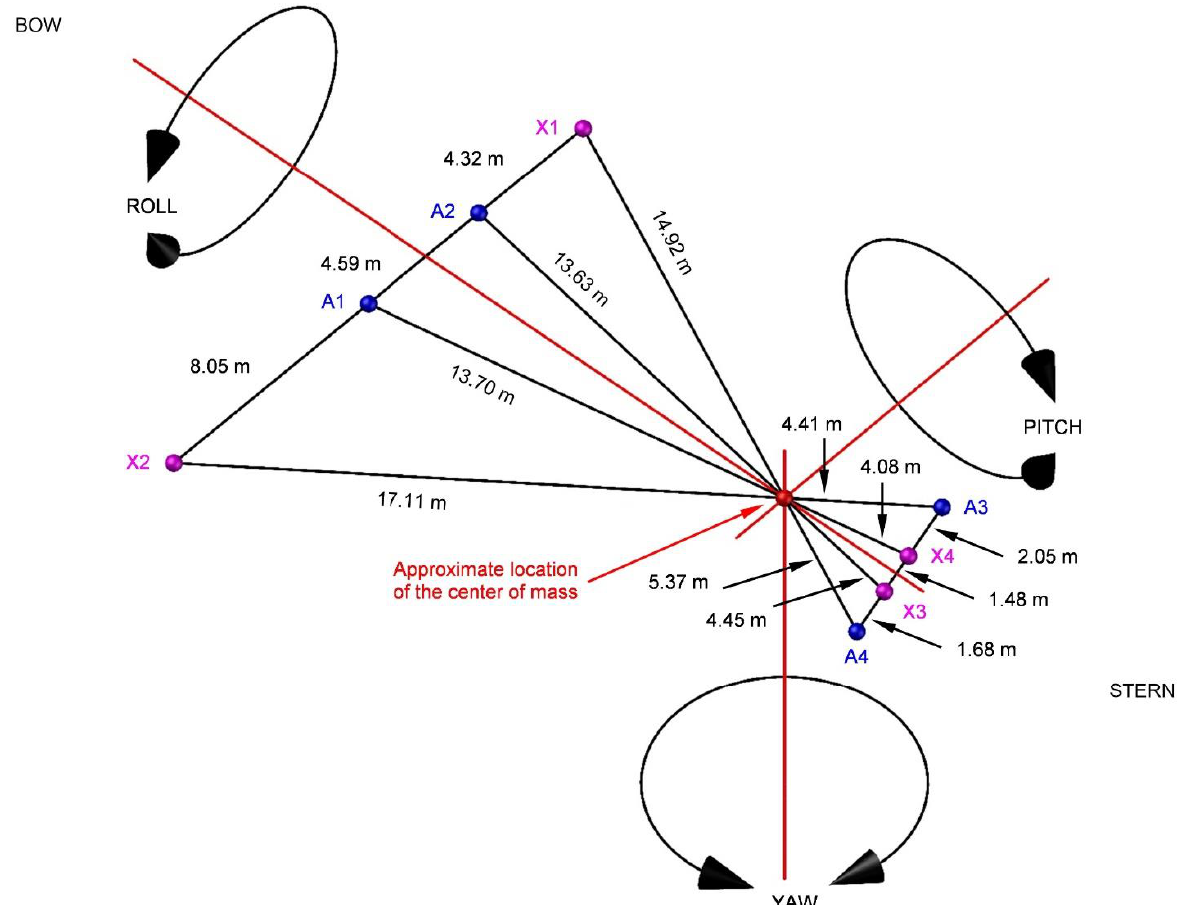
Figure 7. Pitch, roll, and yaw motions of a moving vessel and relative locations of the used GNSS antennas (colored blue). The red lines are the principal axes of the vessel, whereas the black lines denote total station measurement derived distances between antennas and imaginary (magenta colored) intersection points. All points are shown in horizontal projection (i.e., as reduced to the sea surface).